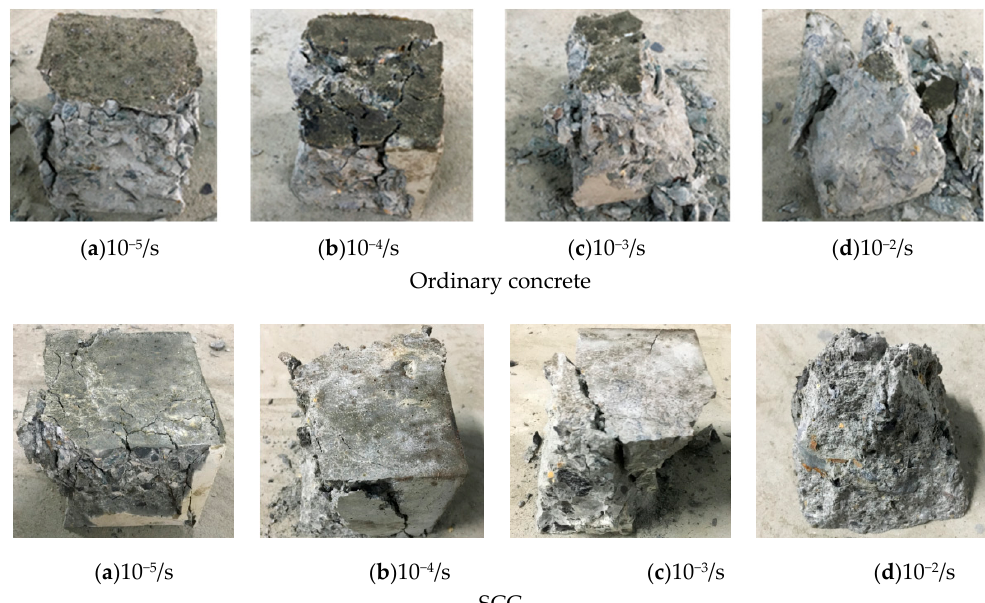
ff erent loading strain